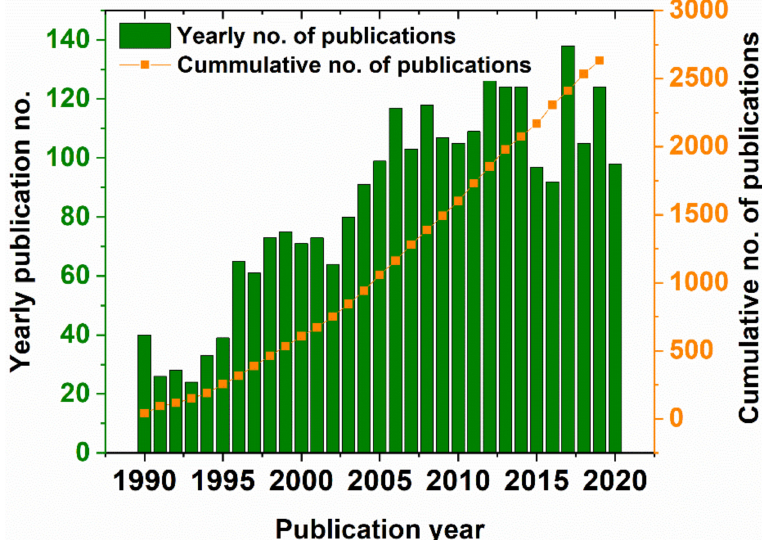
Figure 1. Yearly and cumulative number of publications in the domain of wood preservatives in the 1990–2020 period (Database: Scopus, search terms: “wood” AND “preservative~”, search